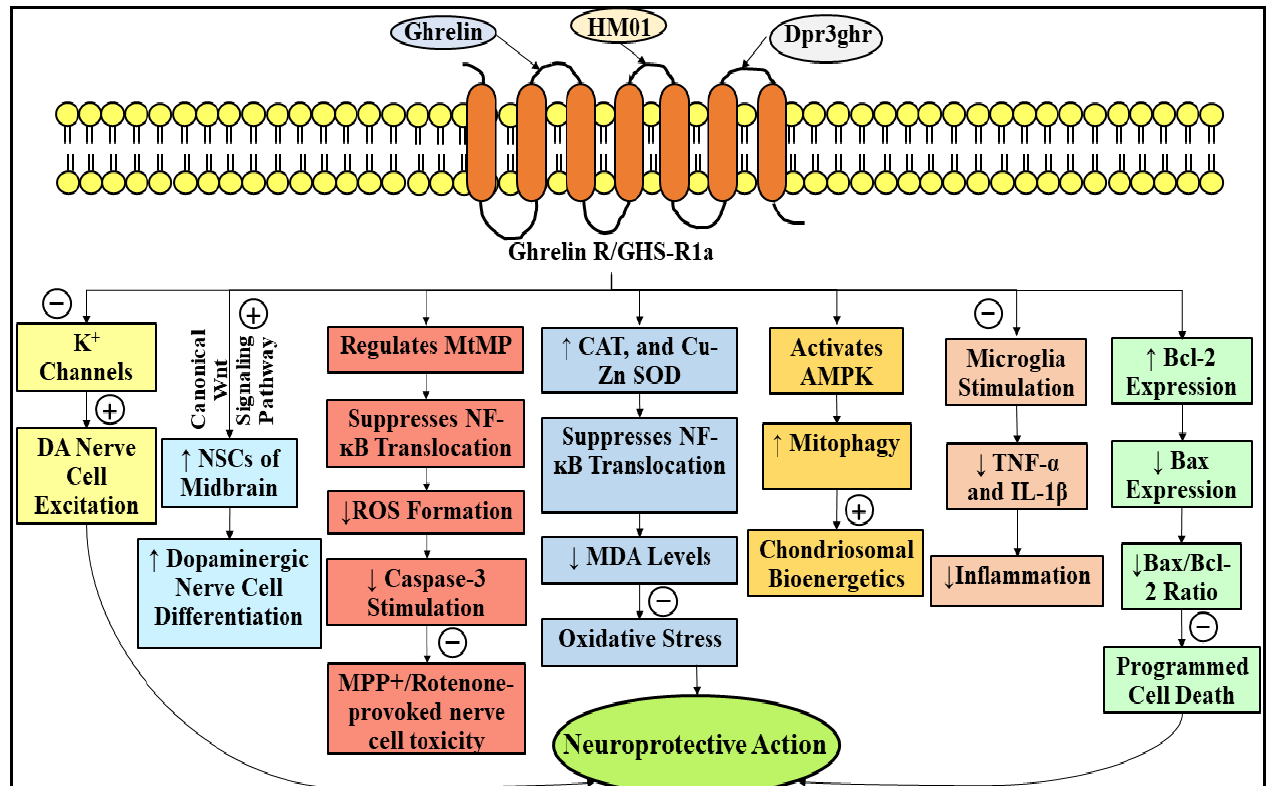
Figure 5. Highlighting the neuroprotective role of ghrelin in Parkinson’s disease. Ghrelin, along with its analogs, namely HM01 and Dpr3ghr, markedly render nerve cell protective actions against MPTP, MPP + , and rotenone-provoked neuronal destruction, via suppressing oxidative stress, programmed cell death, and de-escalating inflammation. Ghrelin, following its interaction with ghrelinR/GHS-R1a, suppresses K + channels, which, as a consequence, contributes to DA nerve cell excitation. In addition, ghrelin, by means of the canonical Wnt signaling pathway, increases the number or amount of NSCs of the midbrain and in vitro and ex vivo DArgic nerve cell differentiation. Moreover, ghrelin treatment regulates MtMP, suppresses mitochondrial complex-I operation, de-escalates ROS formation and caspase-3 stimulation, and eventually restrains nerve cells from MPP + or rotenone-instigated detrimental repercussions. Additionally, ghrelin escalates the levels of antioxidant biocatalysts, namely CAT and Cu-Zn SOD, de-escalates the MDA levels, and suppresses the NF- κ B translocation, and thereby suppresses the oxidative stress via ceasing the lipid peroxidation and generation of ROS, and finally contributes to nerve cell protective action. Moreover, ghrelin possesses its nerve cell protective action via activating AMPK and escalating the mitophagy, which subsequently culminates in the amplification in the chondriosomal bioenergetics. Furthermore, therapy with the assistance of ghrelin culminates in the suppression of microglia stimulation, which, as a result, de-escalates inflammation (via de-escalating the levels of TNF- α and IL-1 β ), and finally culminates into nerve cell protective action. Apart from this, the two, namely ghrelin and Dpr3ghr, suppress programmed cell death and possess substantial nerve cell protective action by elevating Bcl-2 expression, and declining Bax expression and the Bax/Bcl-2 ratio. Subtraction symbol indicates inhibitory/suppressing action, while addition symbol indicates stimulatory action. GhrelinR, ghrelin receptor; GHS-R1a, growth hormone secretagogue receptor 1a; K + , potassium; DA, dopamine; NSCs, neural stem cells; DArgic, dopaminergic; MtMP, mitochondrial membrane potential; ROS, reactive oxygen species; MPP + , 1-methyl-4- phenylpyridinium ion; CAT, catalase; Cu-Zn SOD, copper-zincsuperoxide dismutase; NF- κ B, Nuclear Factor kappa-light-chain-enhancer of activated B cells; MDA, malondialdehyde; AMPK, 5 ′ adenosine monophosphate-activated protein kinase; TNF- α ,tumor necrosis factor-alpha; IL-1 β , interleukin-1 β ;Bcl-2,B-cell lymphoma-2; Bax, Bcl-2-associated X protein; MPTP, 1-methyl-4-phenyl- 1,2,3,6-tetrahydropyridine; ↑ , increasing; ↓ , decreasing.